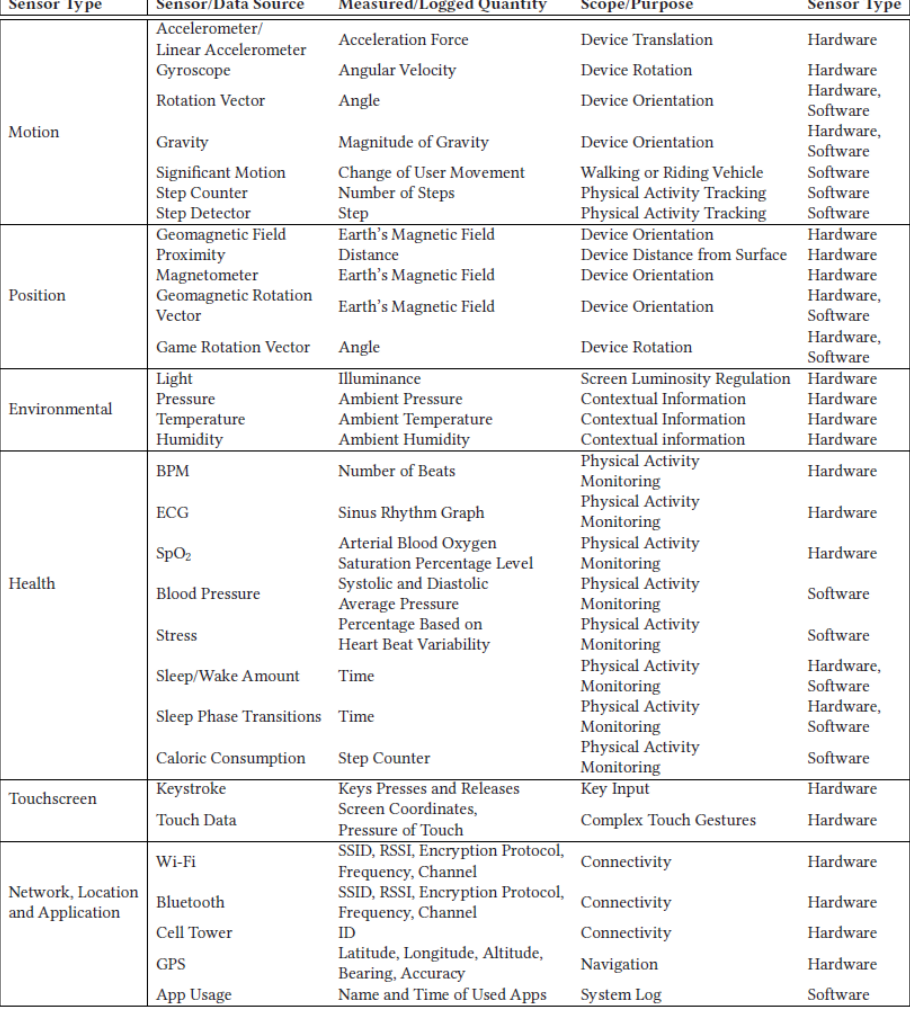
Figure 1. Sensors and raw data specific to modern mobile